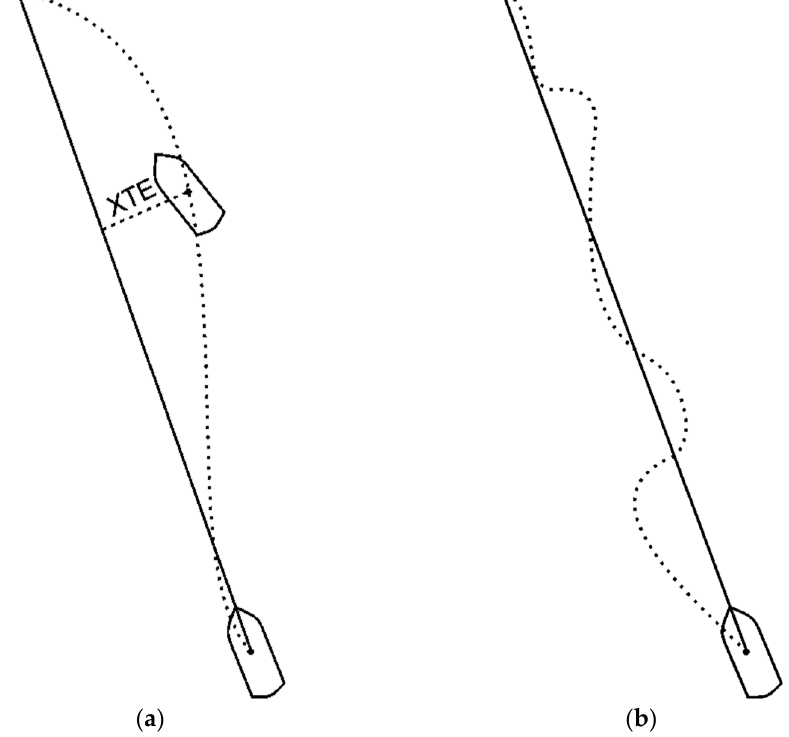
Figure 2. Principles of controlling the movement of a hydrographic vessel: ( a ) the value of the deviation from the planned route (Cross Track Error—XTE), and ( b ) the results in the movement of a vessel’s centre of gravity.